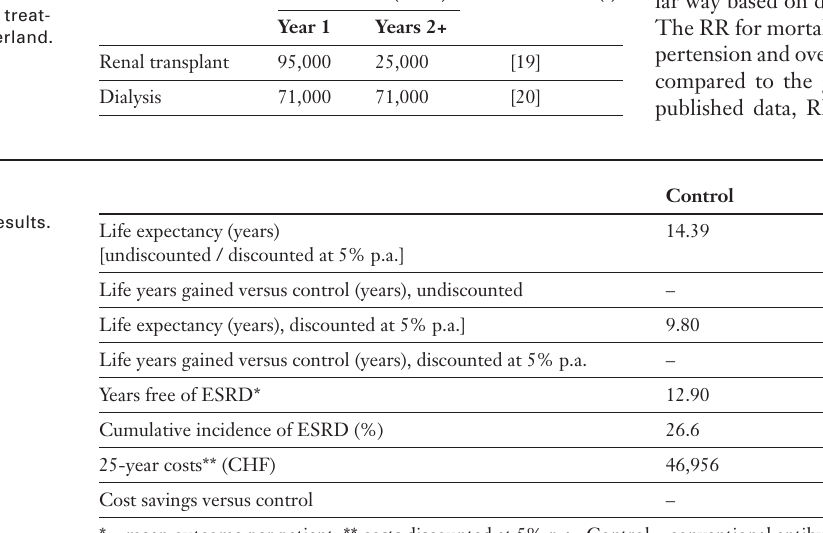
Costs of ESRD treat- ment in Switzerland.